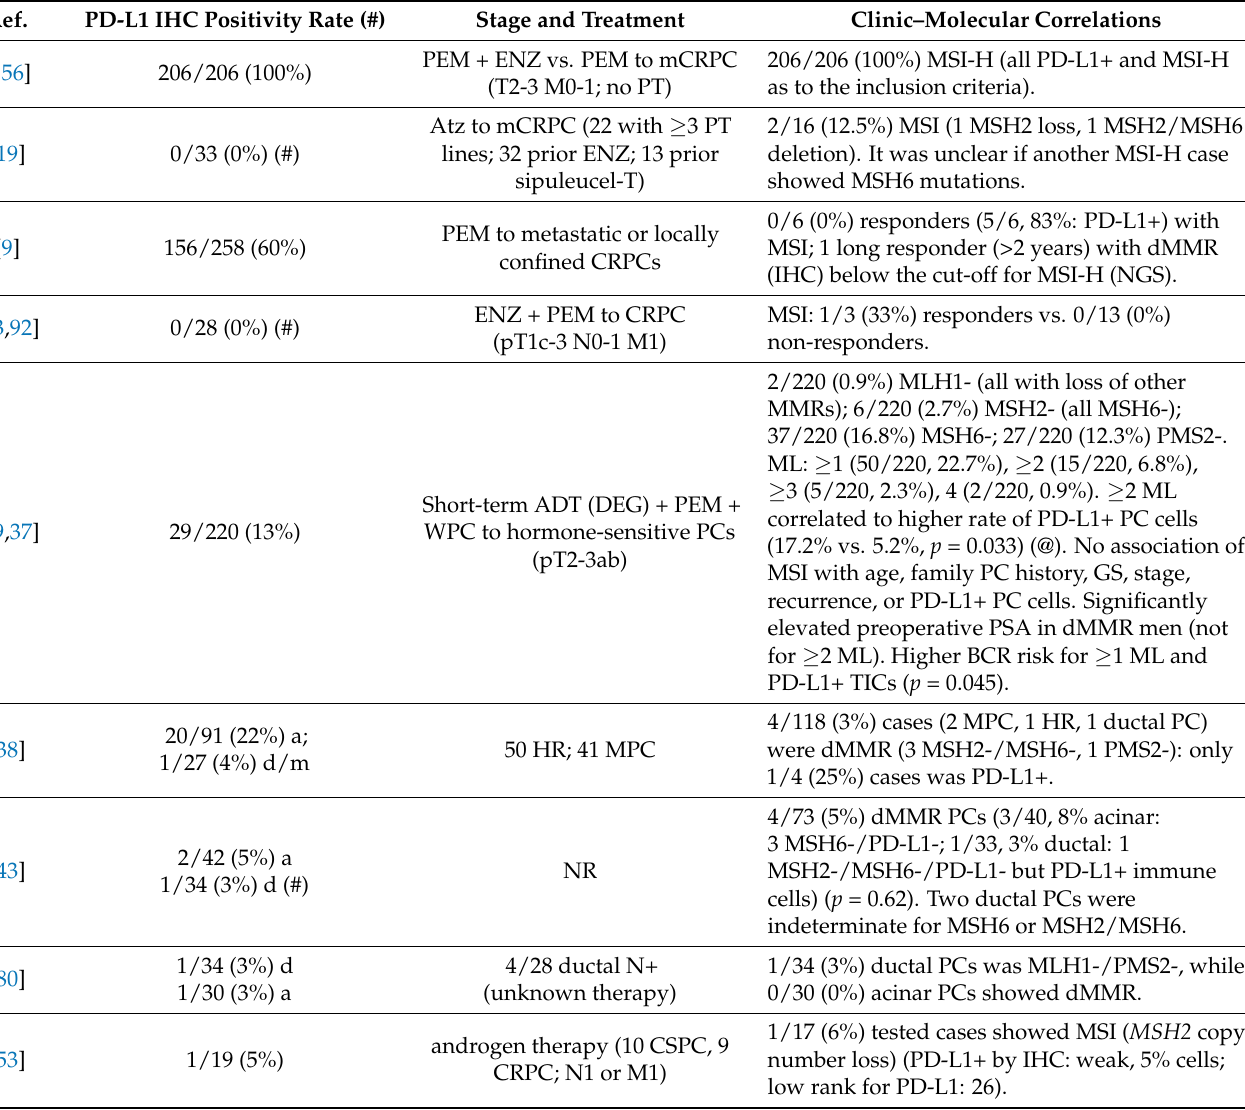
Table 1. PD-L1 expression and microsatellite instability/mismatch repair system protein status in patients with prostatic